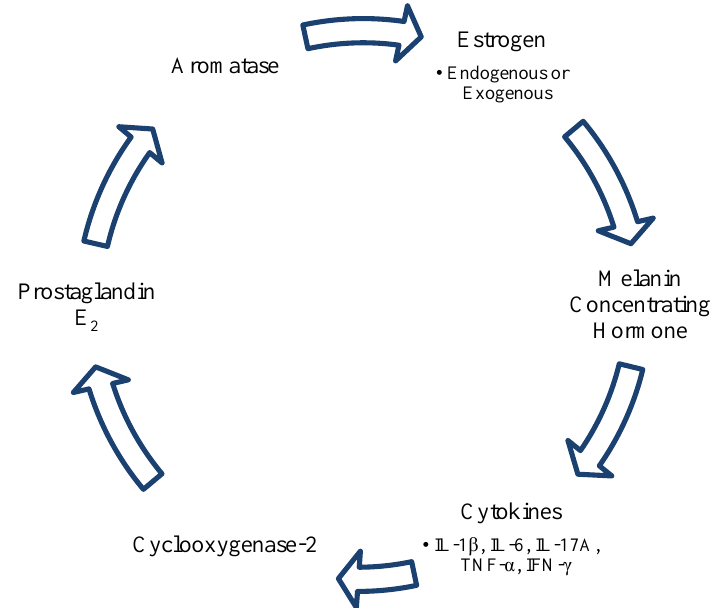
Figure 1. Positive feedback loop of endocrine dysregulation. This endocrine feedback loop is the backbone of understanding the potential biopsychosocial dysregulation observed in